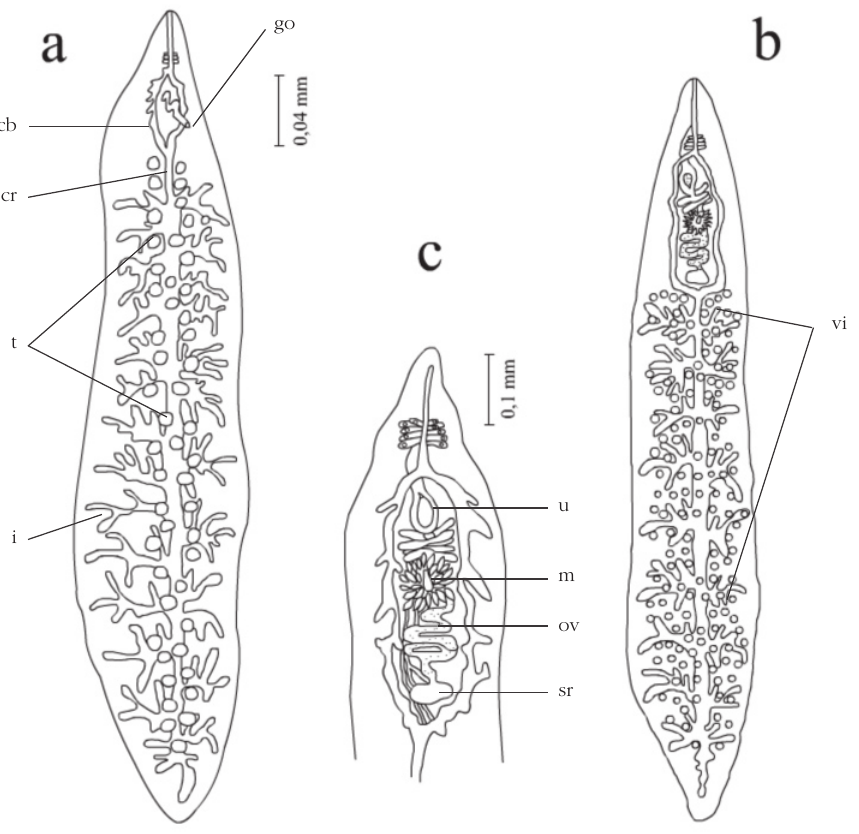
Fig. 6. – Dendritobilharzia loossi Skrjabin, 1924. a: male; b: female; c: topography of sexual organs in